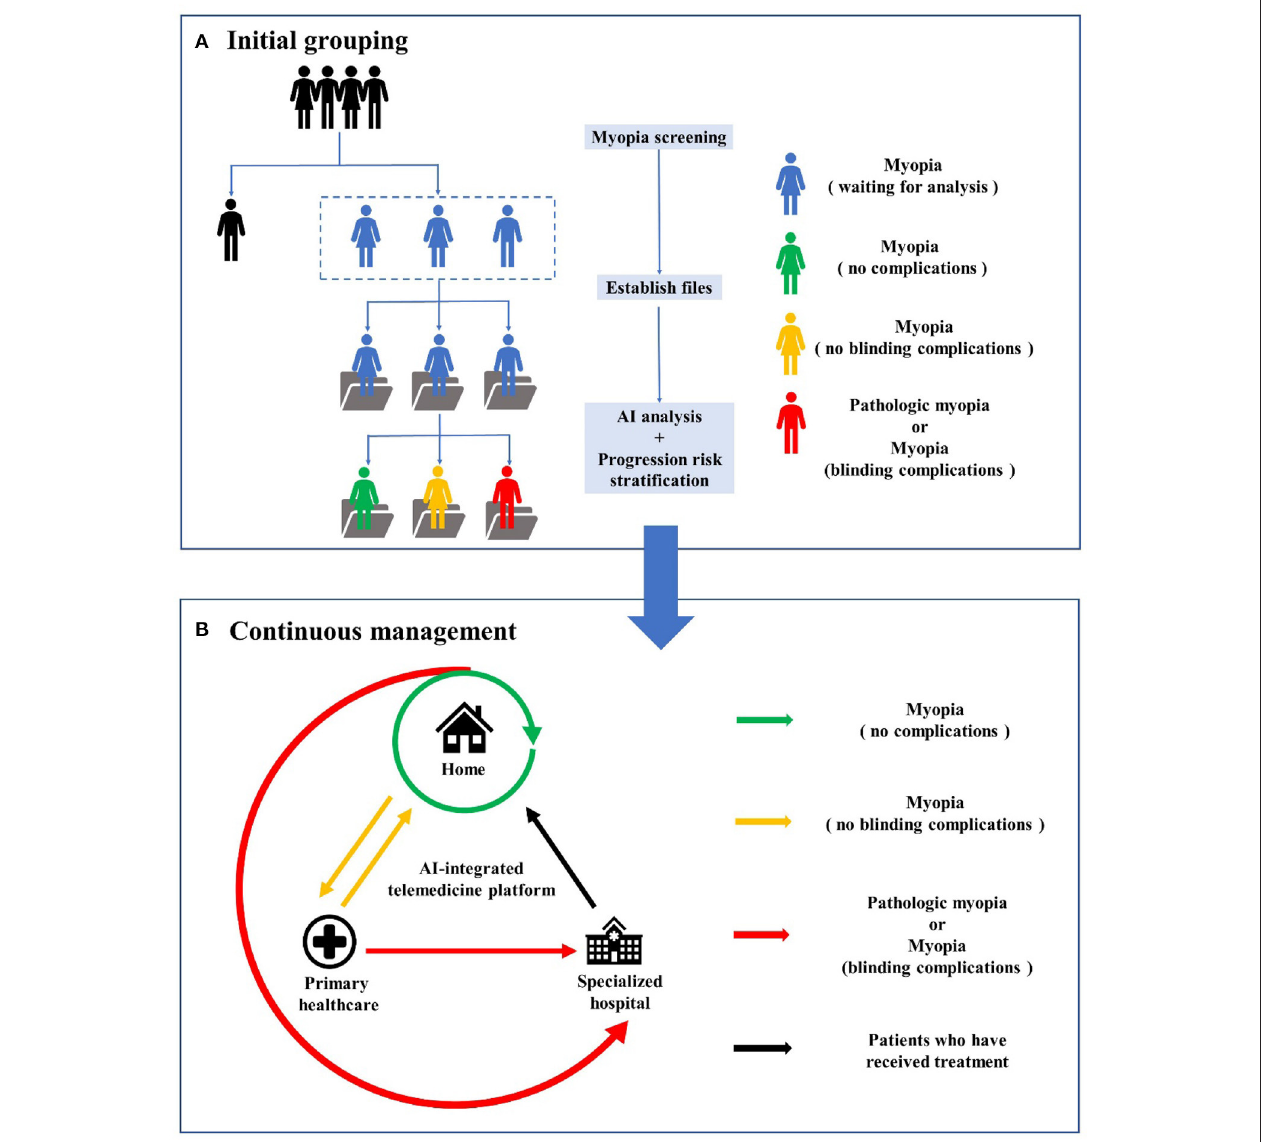
FIGURE 2 | The workflow of AI-integrated telemedicine platform for myopia. (A) is the workflow of initial grouping, including myopia screening, files establishing, AI analysis and progression risk stratification for myopia patients. (B) is the workflow of continuous management involving self-monitoring at home, primary healthcare and specialized hospital